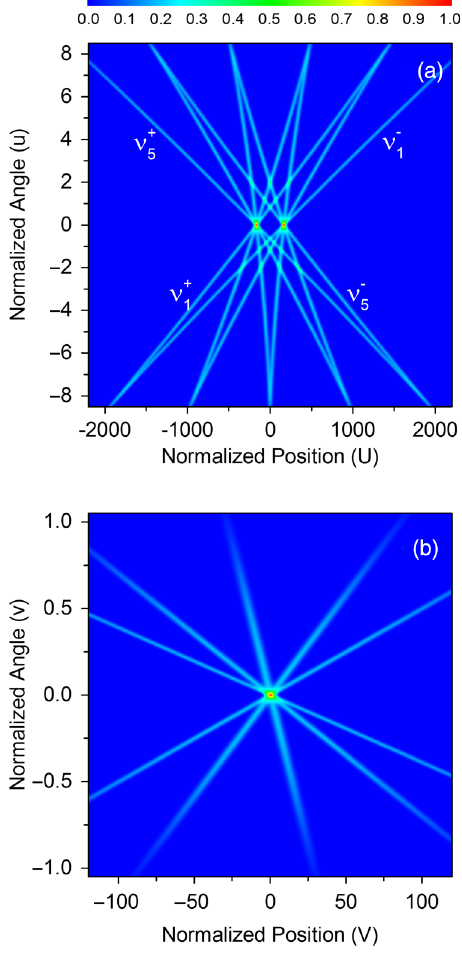
FIG. 5. Normalized Wigner function of WR plotted on (a) the ð U; u Þ plane sliced at ð V; v Þ ¼ ð 0 ; 0 Þ and (b) ð V; v Þ plane sliced = χ ; 0 Þ at ð U; u Þ ¼ ð − x a